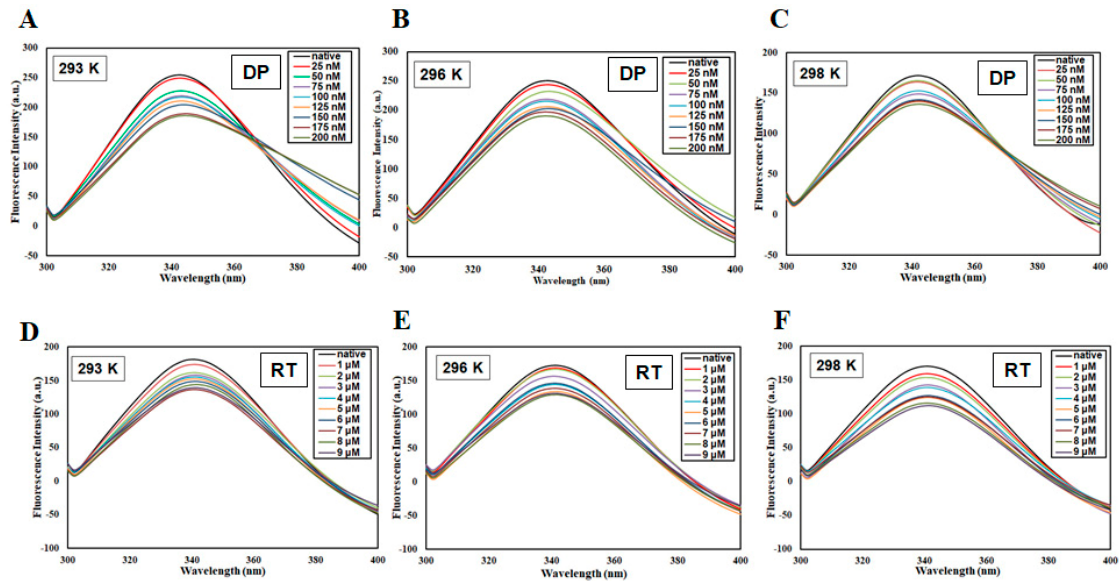
Figure 1. Steady-state fluorescence of MARK4 in the presence of DP (0 − 200 nM) at ( A ) 293 K, ( B ) 296 K, and ( C ) 298 K, and RT (0 − 9 µ M) at ( D ) 293 K, ( E ) 296 K, and ( F ) 298 K. The concentration of MARK4